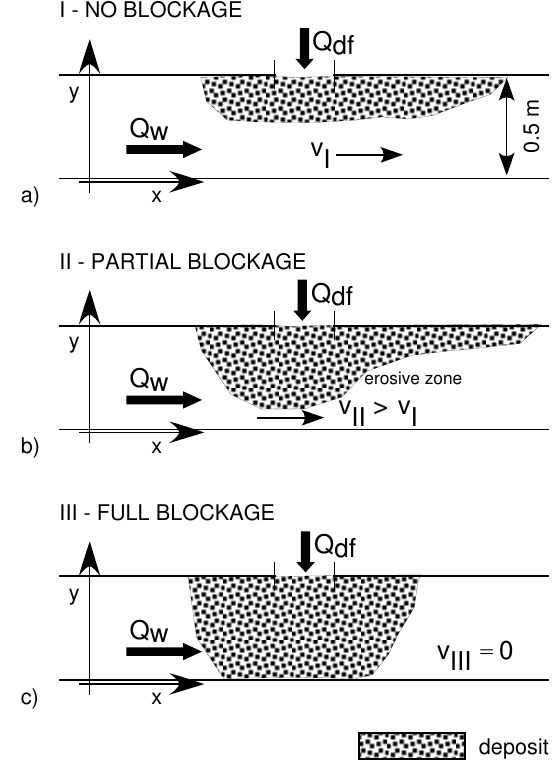
Figure 4. Sketches of the different blockage conditions observed during the flume experiments in relation to different values of the ratio of the debris flow volumetric discharge Q df to the water discharge Q w flowing in the main channel: ( a ) no blockage; ( b ) partial blockage; ( c ) full